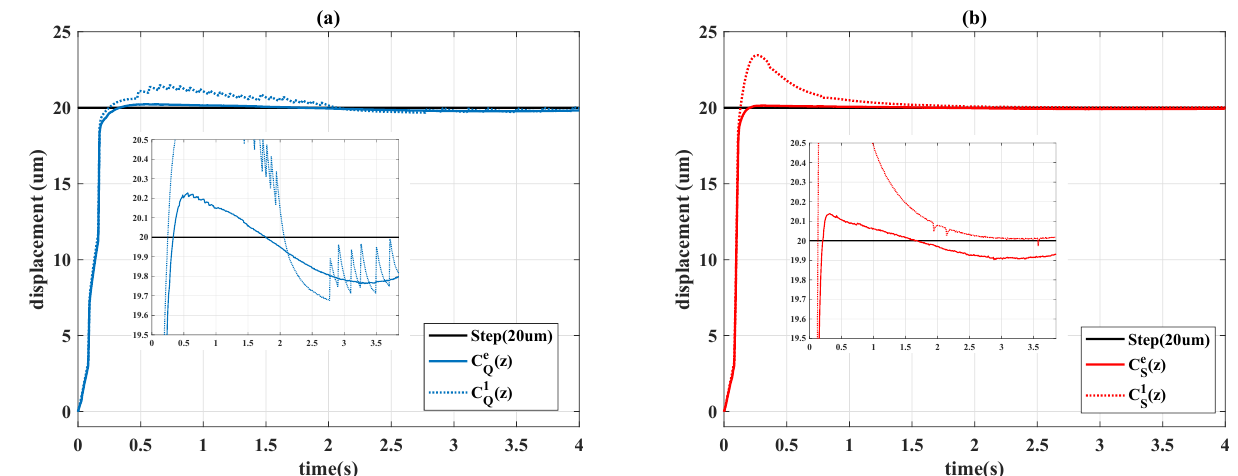
Figure 18. Output responses of: ( a ) Q-learning controllers; ( b ) Sarsa controllers.